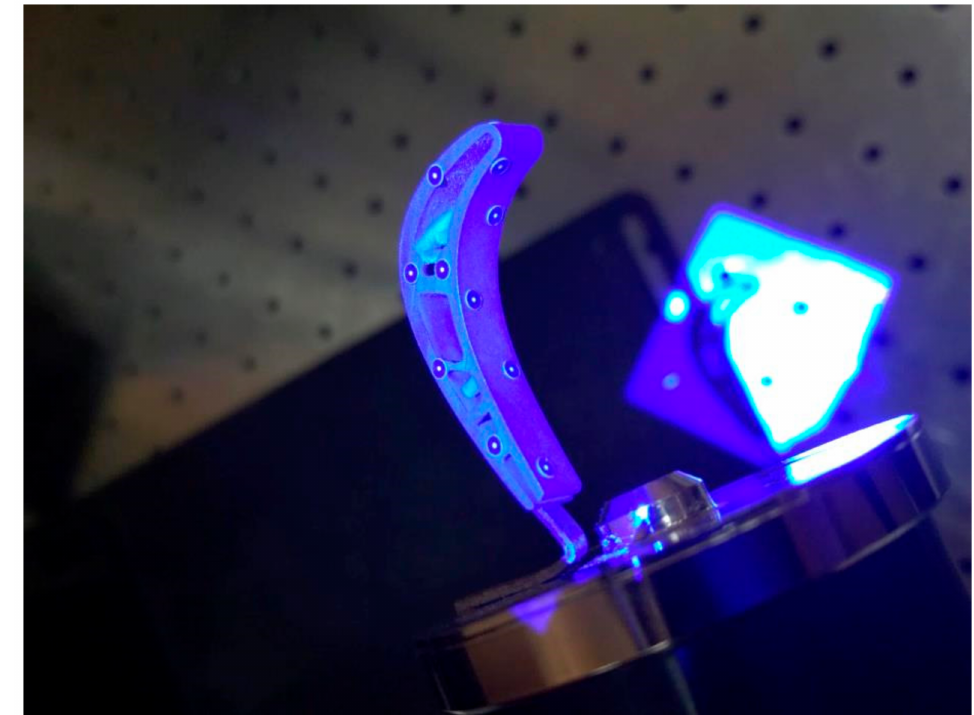
Figure 6. The turbine blade section during the digitization